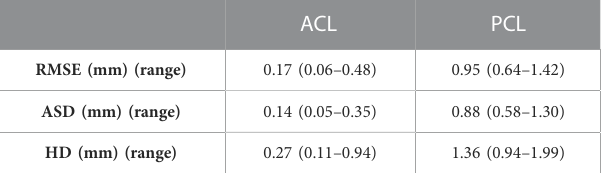
TABLE 7 Median RMSE, ASD and HD with range between predicted and measured thickness of the ACL and